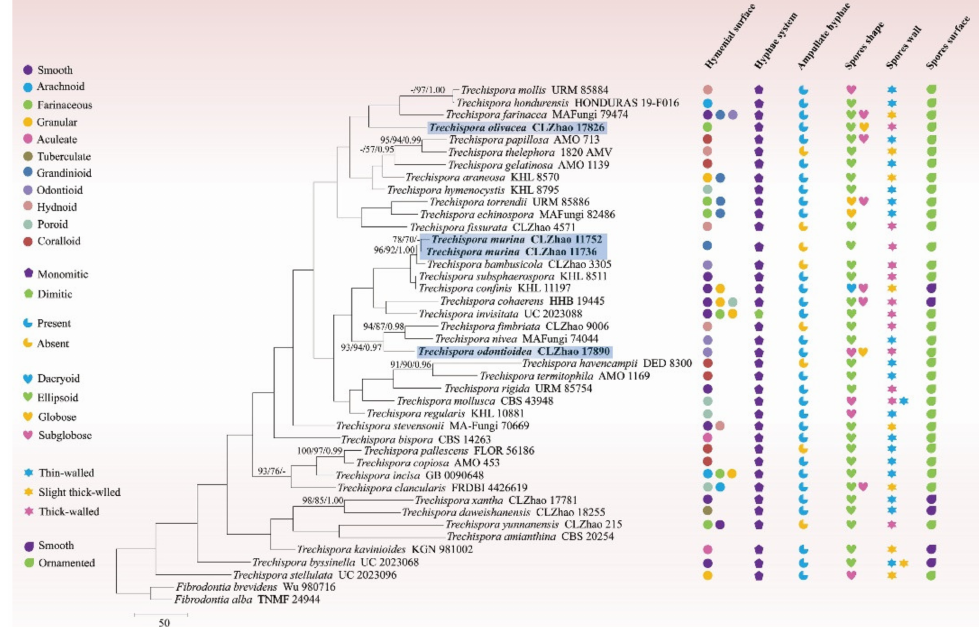
Figure 2. Maximum parsimony strict consensus tree illustrating the phylogeny of three new species and related species in Trechispora based on ITS sequences. Branches are labelled with maxi- mum likelihood bootstrap value (cid:61) 70%, parsimony bootstrap value (cid:61) 50%, and Bayesian posterior probabilities (cid:61) 0.95, respectively. The new species are in